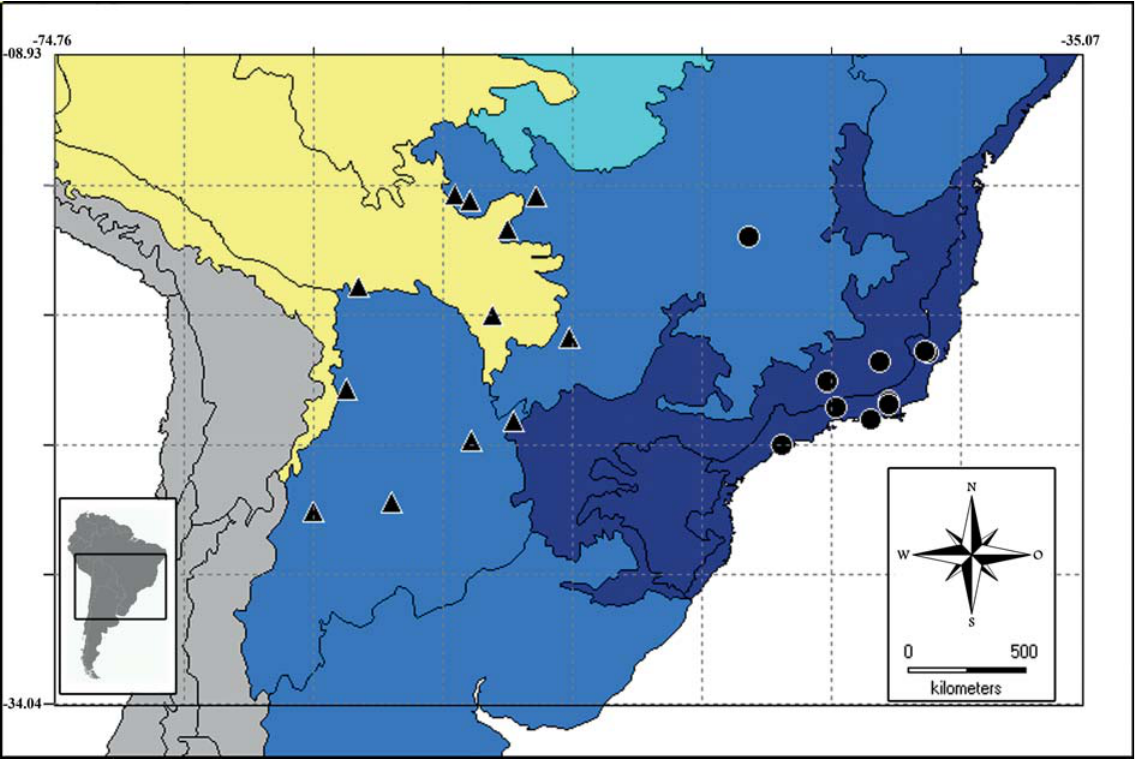
Fig. 10. Geographical distribution of Canthidium gigas Balthasar, 1939 (circles) and Canthidium bokermanni (Martínez et al., 1964)